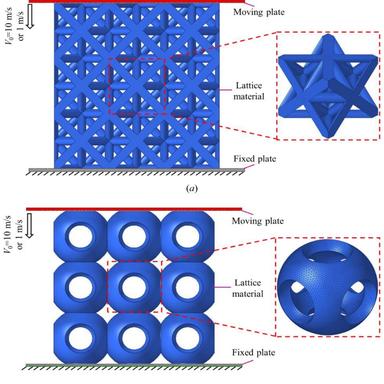
FE models of (a) Octet lattice material; (b) BCC-6H lattice material.